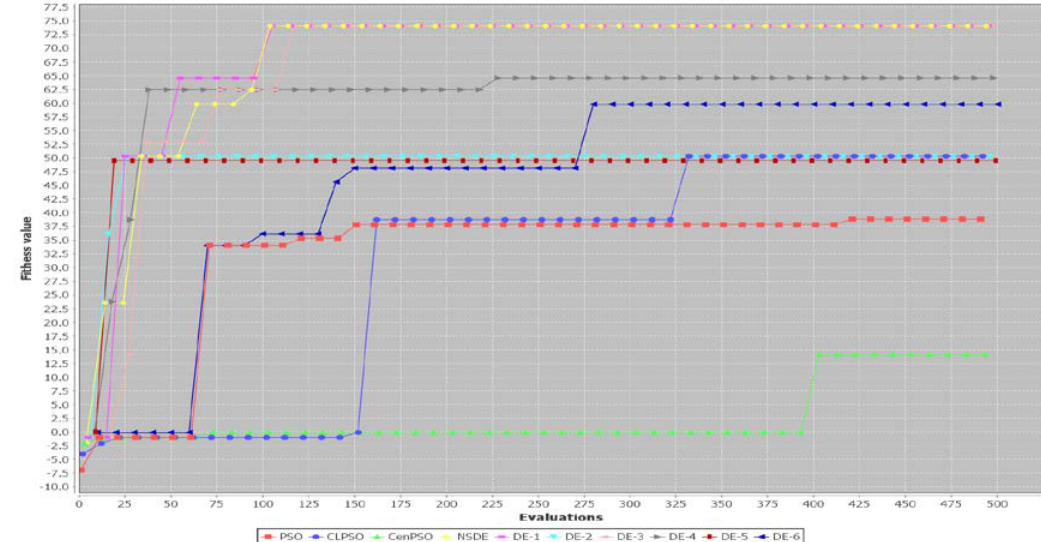
Figure A9. Convergence speed of a run of each algorithm for Case 9 with POP = 30.